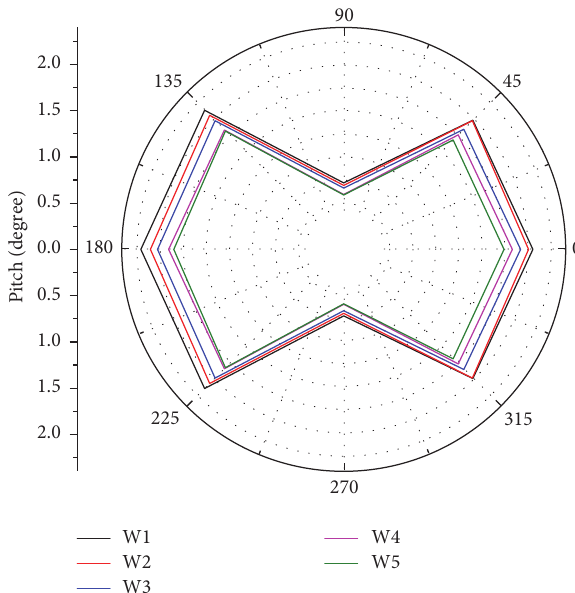
Figure 14: Results of pitch in irregular